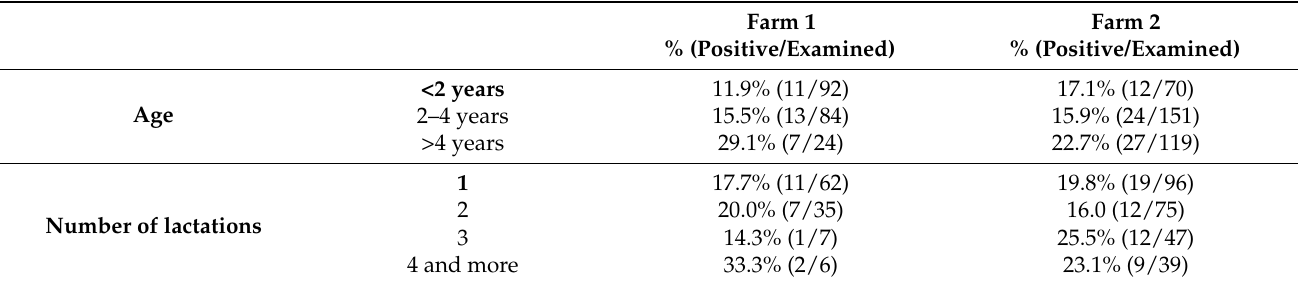
Table 2. Serological prevalence of Neospora caninum infection in cattle from two farms in northern Italy according to both age and number of